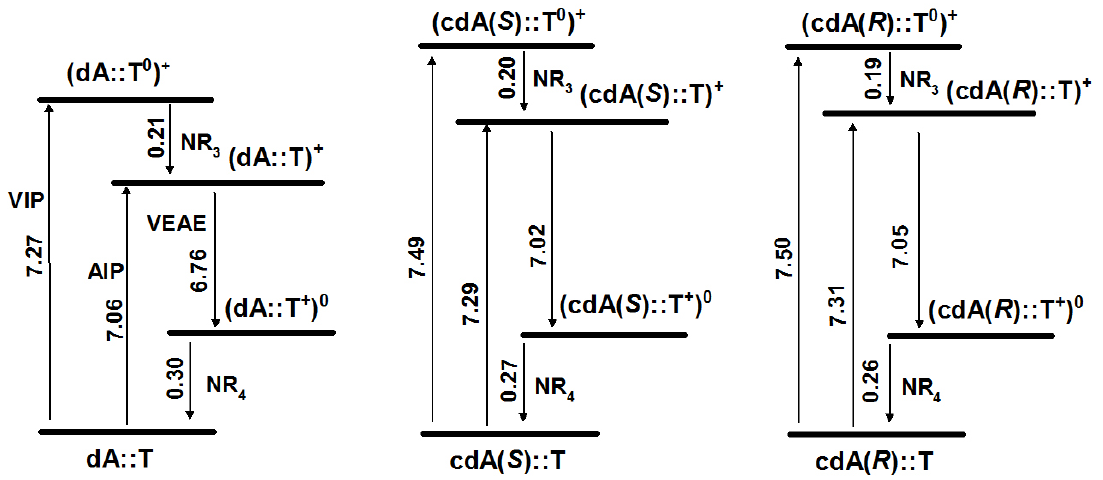
Figure 3. The visualization of high occupied molecular orbital (HOMO) of the optimized anionic form of nucleoside pairs: A ) [dA::T] − , B ) [cdA(R)::T] − and C ) [cdA(S)::T] − and low unoccupied molecular orbital (LUMO) of the optimized neutral form of A ) cdA(S)::T . cdA(R)::T and C 1